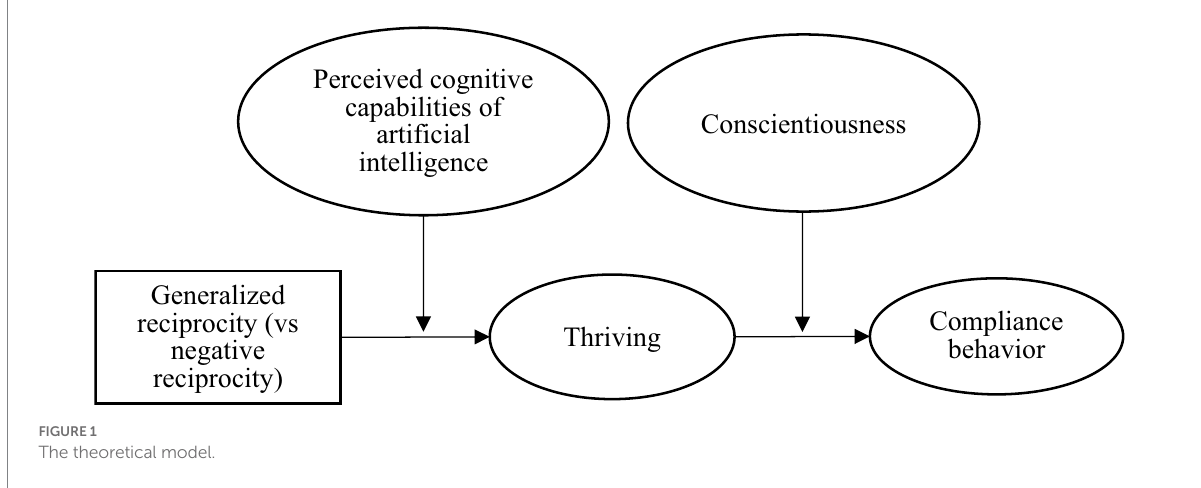
FIGURE 1 The theoretical